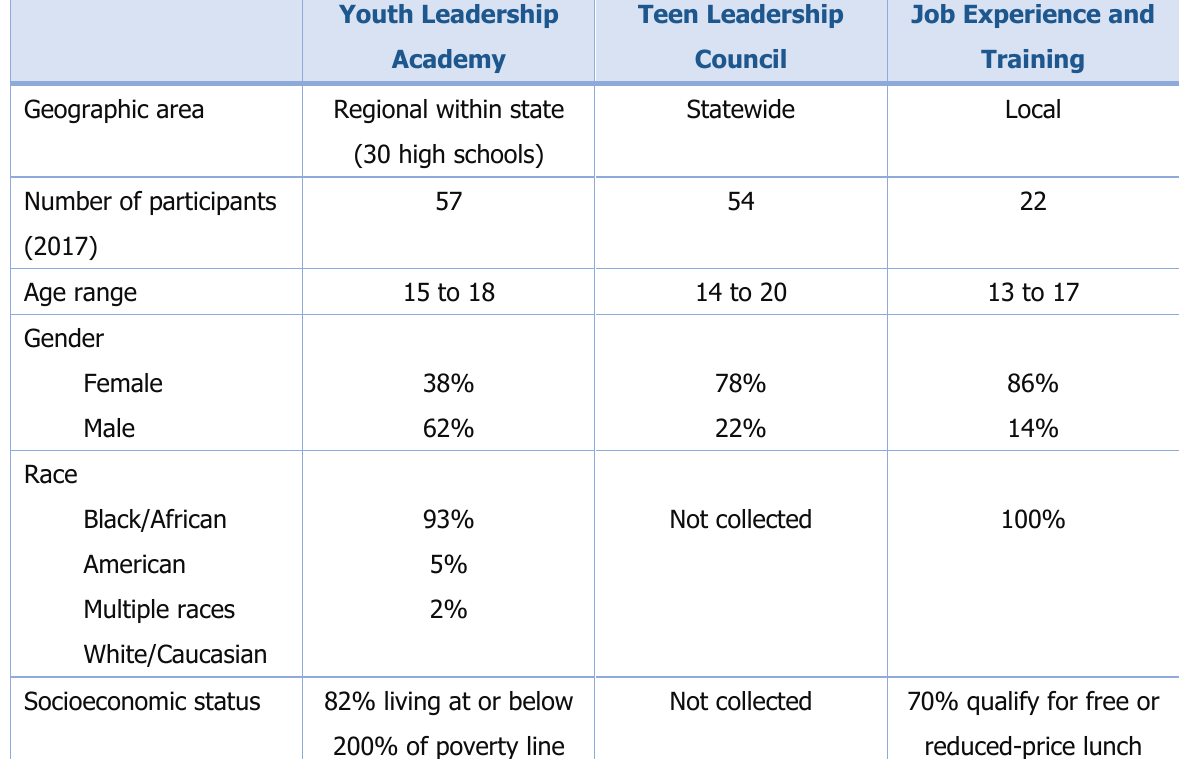
Table 1. Characteristics of Youth Leadership Program